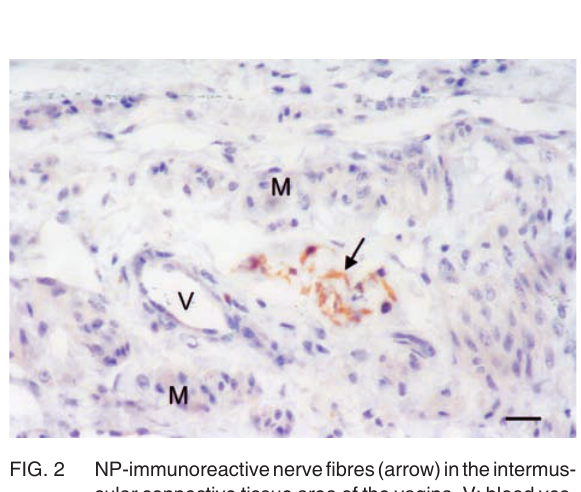
FIG. 2 NP-immunoreactive nerve fibres (arrow) in the intermus- cular connective tissue area of the vagina. V: blood ves- sel. M: smooth muscle cells Scale bar = 50 μ m